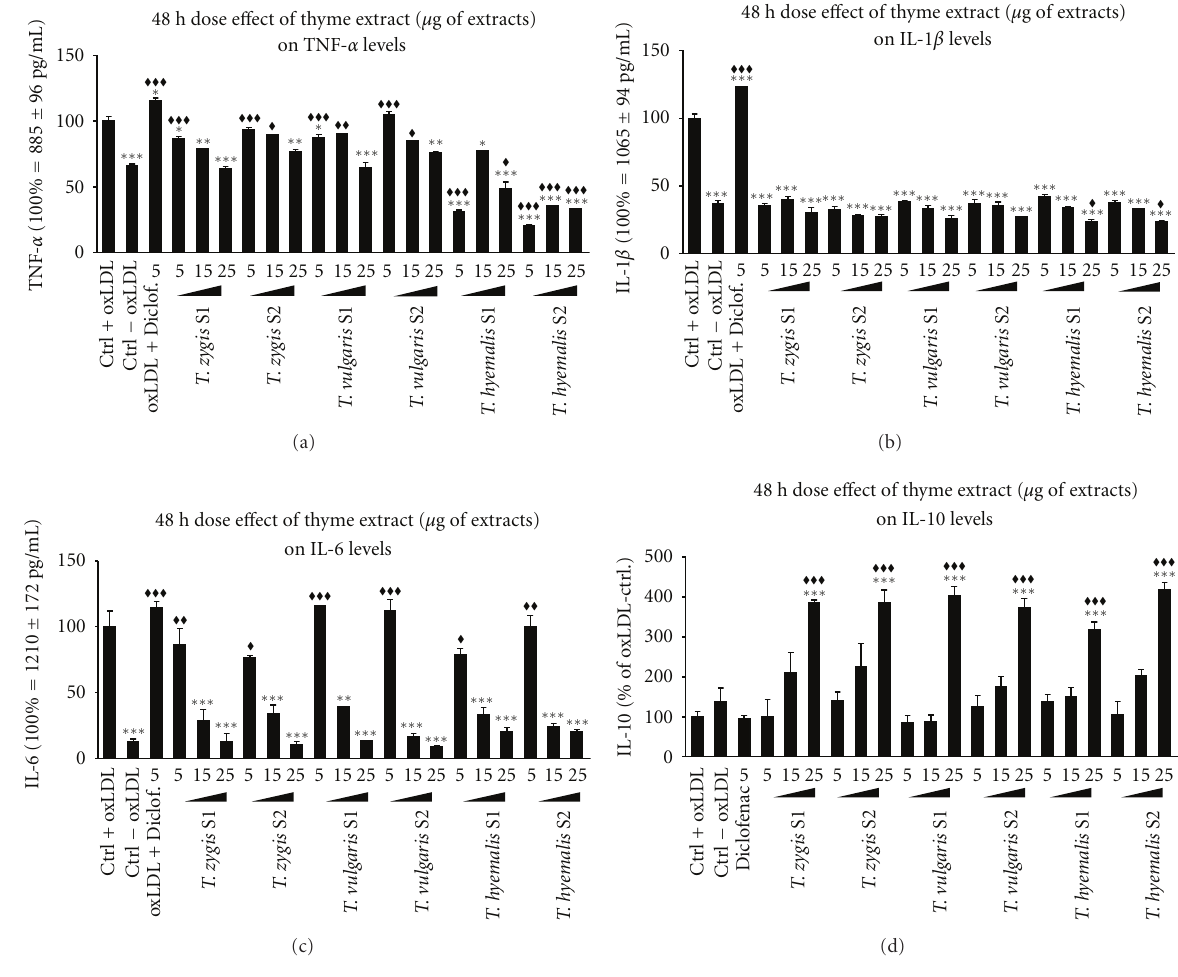
Figure 4: Dose e ff ect of 5, 15, and 25 μ g/mL of thyme extracts S1 and S2 from three di ff erent species ( Thymus vulgaris, Thymus zygis, and Thymus hyemalis ) on the production and secretion of TNF- α (a), IL-1 β (b), IL-6 (c), and IL-10 (d) on macrophage-THP-1 cells. Cells were di ff erentiated with (PMA) 100 ng/mL for 24 h and afterwards treated as described in Section 3 for 48 hours. Data represent means ± SEM calculated from six independent experiments with 3 replications for each treatment. Statistic Dunnett’s multiple comparison test versus Ctrl +oxLDL signification is represented by ∗ P values less than 0.05, significant; ∗∗ P values less than 0.01, very significant; and ∗∗∗ P values less than 0.001, extremely significant. One group was treated with a small concentration of diclofenac (5 μ g/mL) as positive standard control. Statistic Bonferroni multiple comparison test versus Ctrl − oxLDL signification is represented by (cid:3)(cid:3) P values less than 0.01, very significant; and (cid:3)(cid:3)(cid:3) P values less than 0.001, extremely significant.